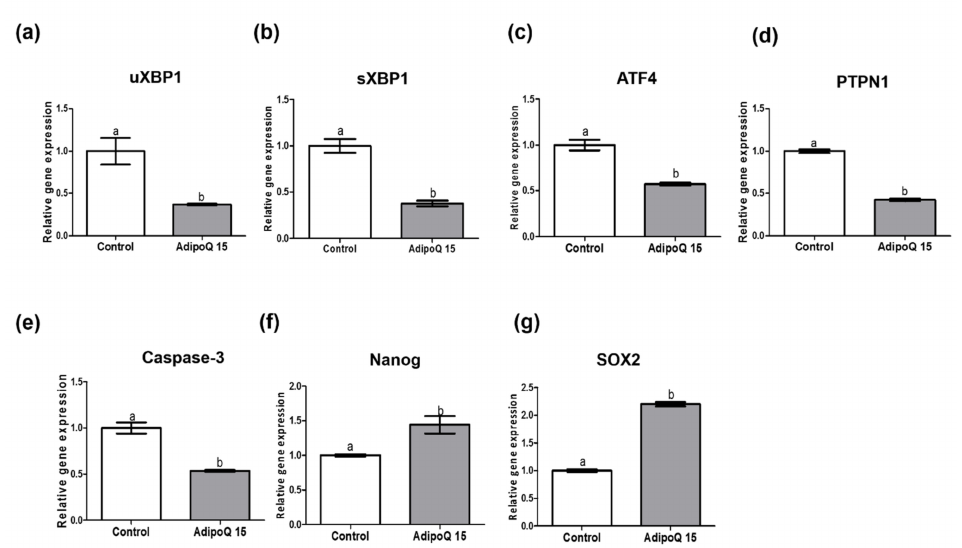
Figure 3. Relative expression levels of unfolded protein response-related mRNAs ( uXBP1 , sXBP1 , ATF4 , PTPN1 ), Caspase -3, Nanog, and SOX2 in ≥ 4-cell embryos (day 2) derived from somatic cell nuclear transfer embryos ( a – g ). Data are